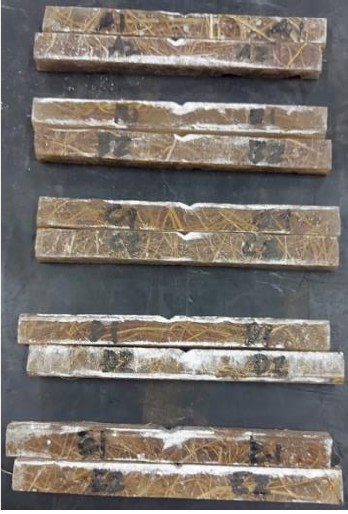
Figure 6. Impact Specimen.